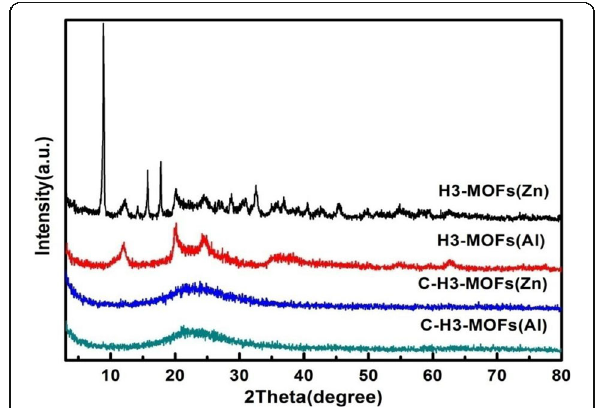
Fig. 2 XRD patterns of H3-MOFs(Zn), H3-MOFs(Al), C-H3-MOFs(Zn), and C-H3-MOFs(Al) samples